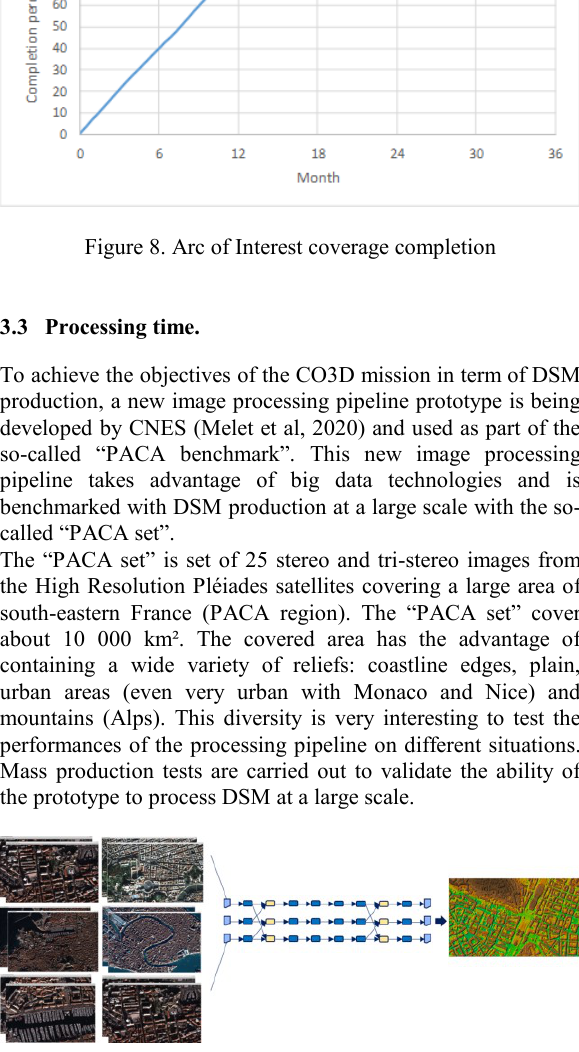
Figure 9. Paradigm for